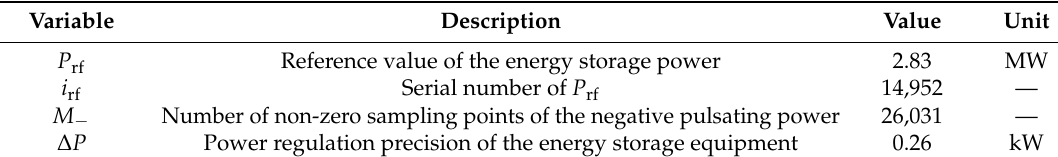
Table 1. Parameters of the simulated wind- storage hybrid power system.